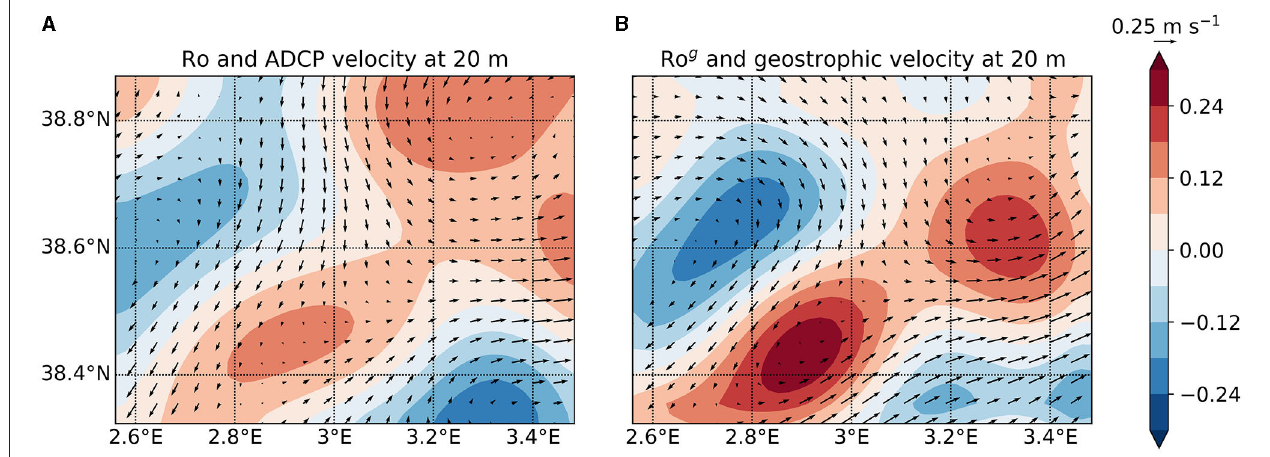
FIGURE 7 | Maps at 20 m depth of (A) Ro with ADCP velocity vectors and (B) Ro g with geostrophic velocity vectors. For clarity, only one out of two current vectors are plotted.